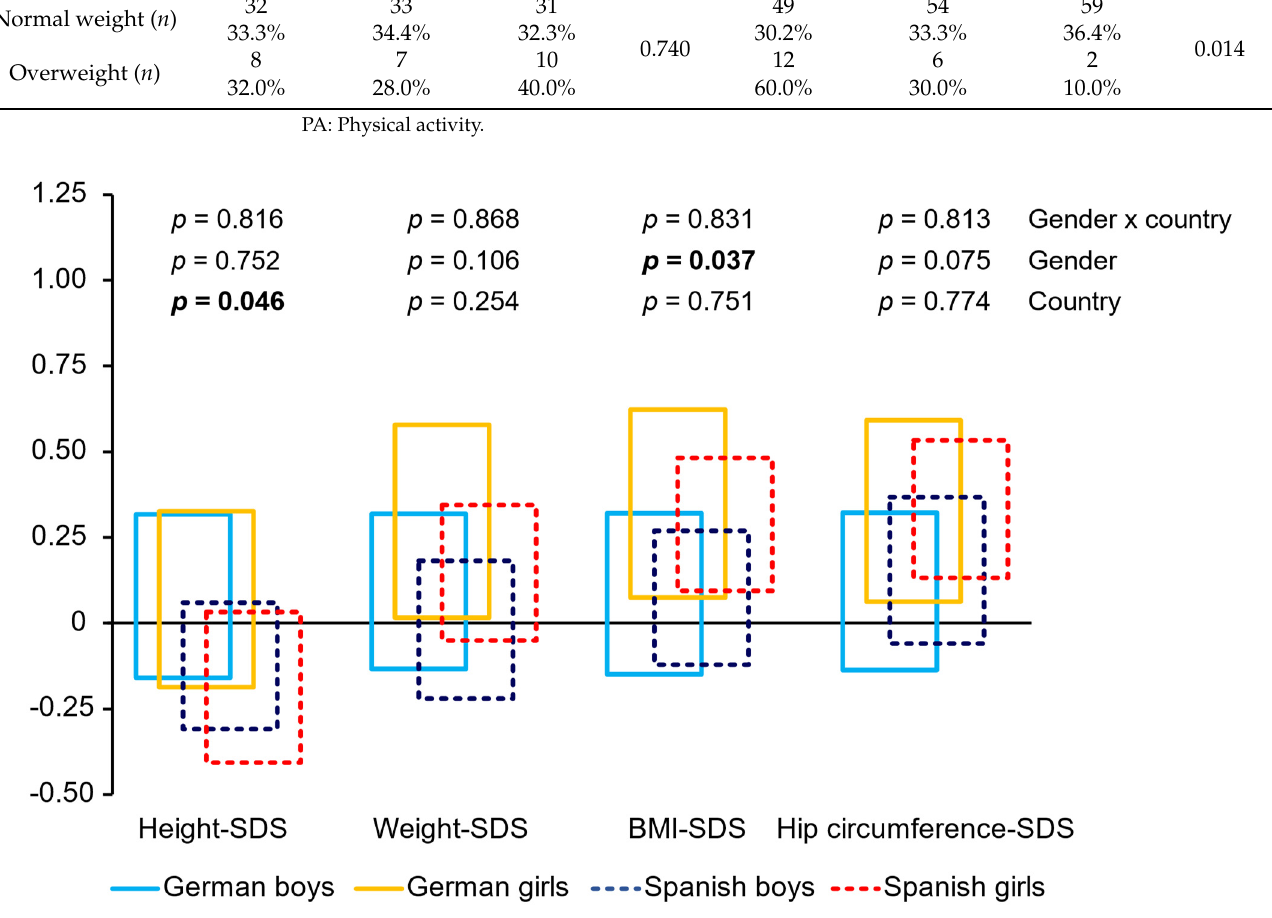
10.0% PA: Physical activity. Table 3 shows the results of the each KIDMED question by country, with 10 out of 13 questions showing significant differences between both countries. The KIDMED score was 3.45 ± 1.99 for Germany and 6.15 ± 1.95 for Spain, with no significant differences be- tween gender (p ANOVA = 0.078) and the interaction gender and country (p ANOVA = 0.486), but it differed significantly between the two countries (p ANOVA < 0.001; η 2 = 0.32).